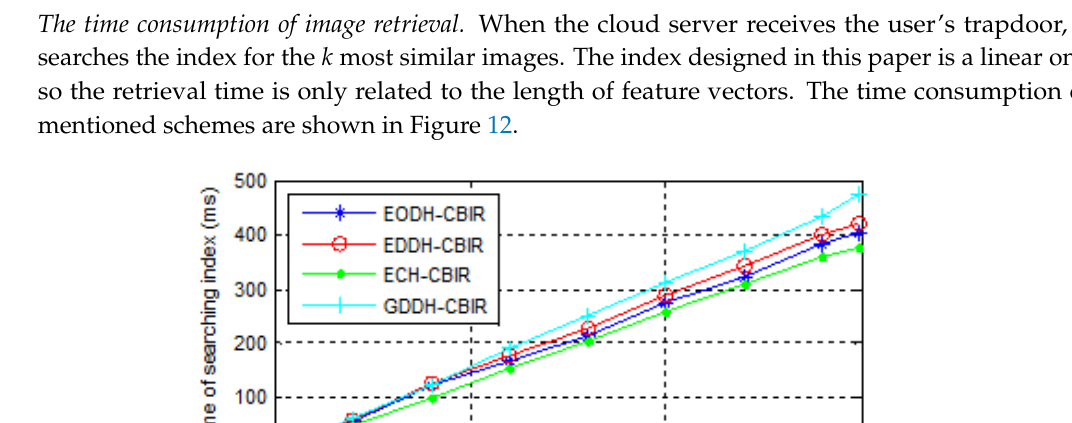
Figure 11. The time consumption of index construction.